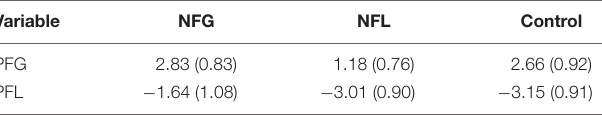
TABLE 4 | Means (and SDs) for frame of NF and frame of PF (Study 3). Variable NFG NFL Control PFG